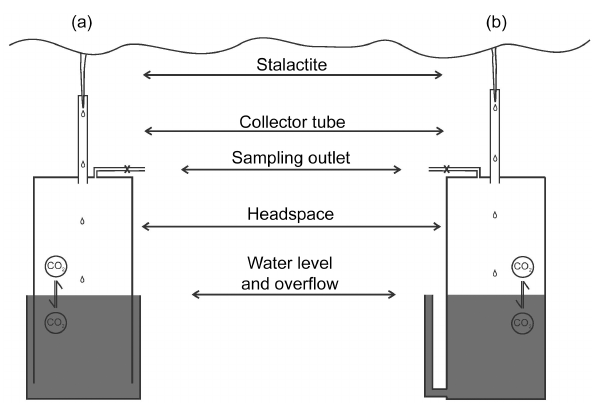
Figure 3. Schematic of the two water–air equilibrators used for the measuring of drip water CO 2 : Type A (a) and Type B (b)